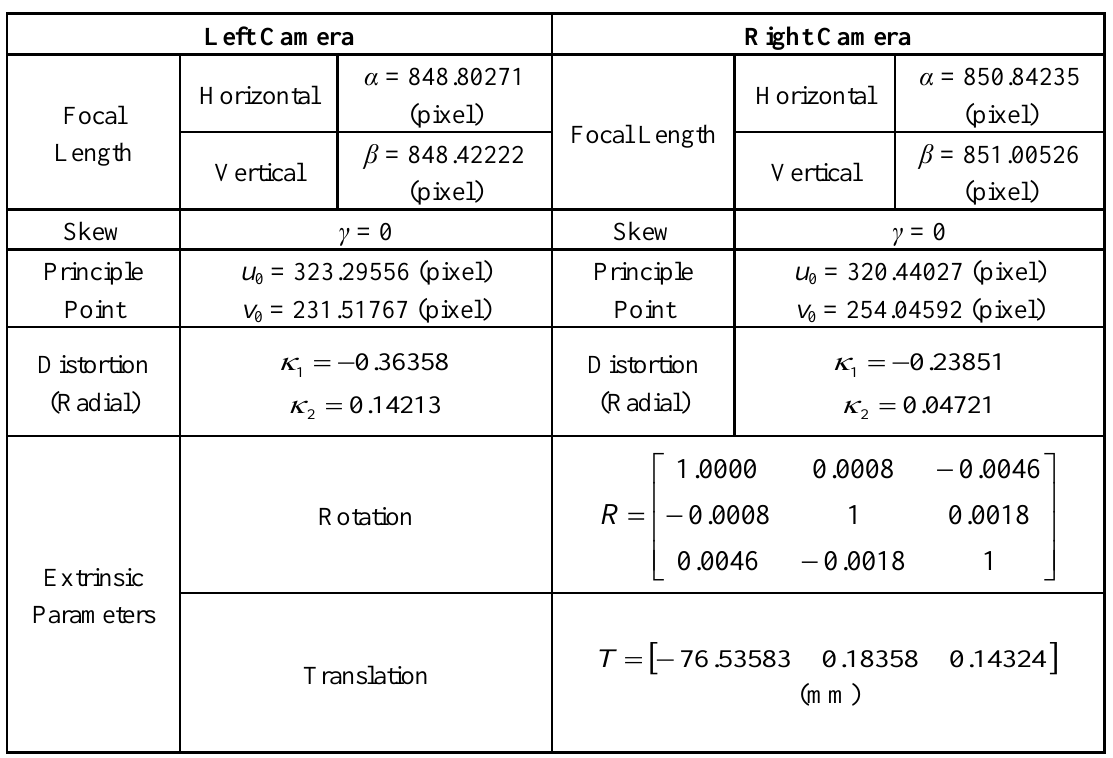
Table 2. The intrinsic and extrinsic parameters of the stereo